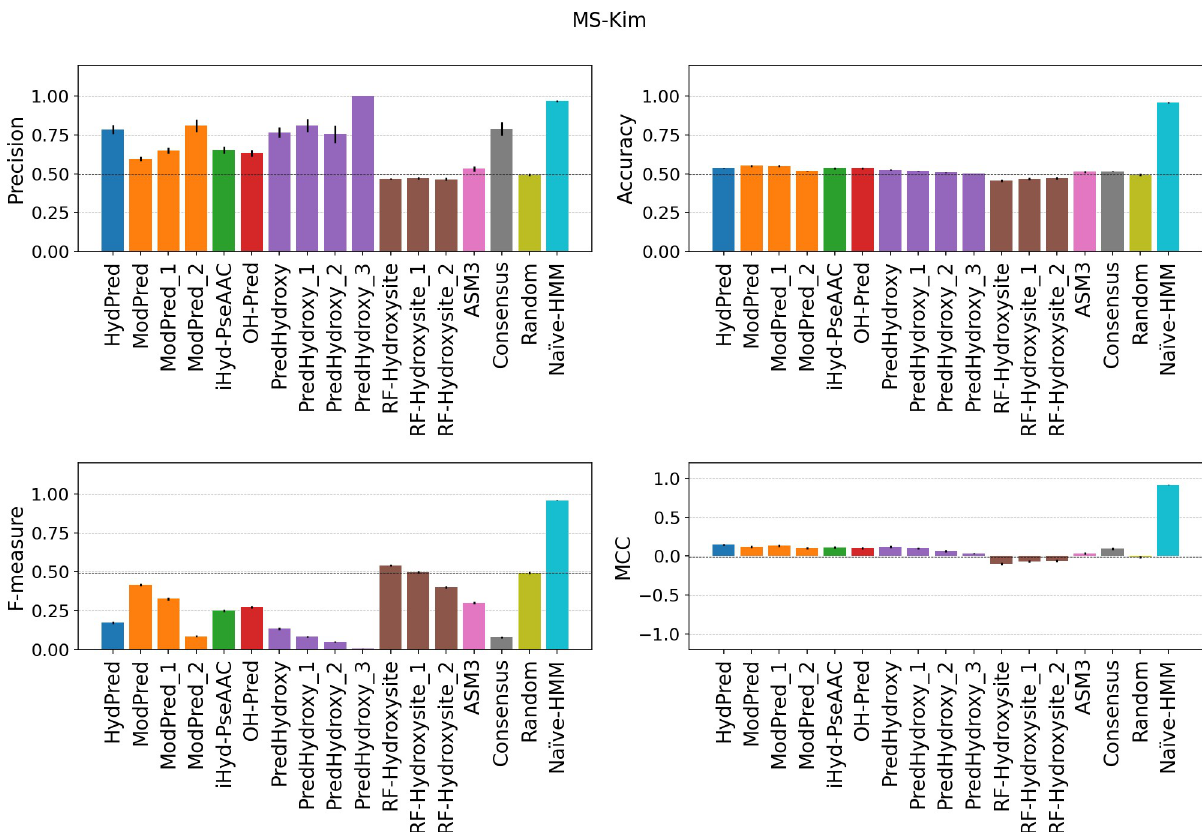
Fig 3. Performance on the MS-Kim datasets. The evaluation is performed only considering hydroxylated sites detected by a mass-spectrometry experiment (MS-Kim dataset). Consensus and errors are calculated as in the previous figure. Suffix numbers in the method names indicate increasing quality threshold as defined by